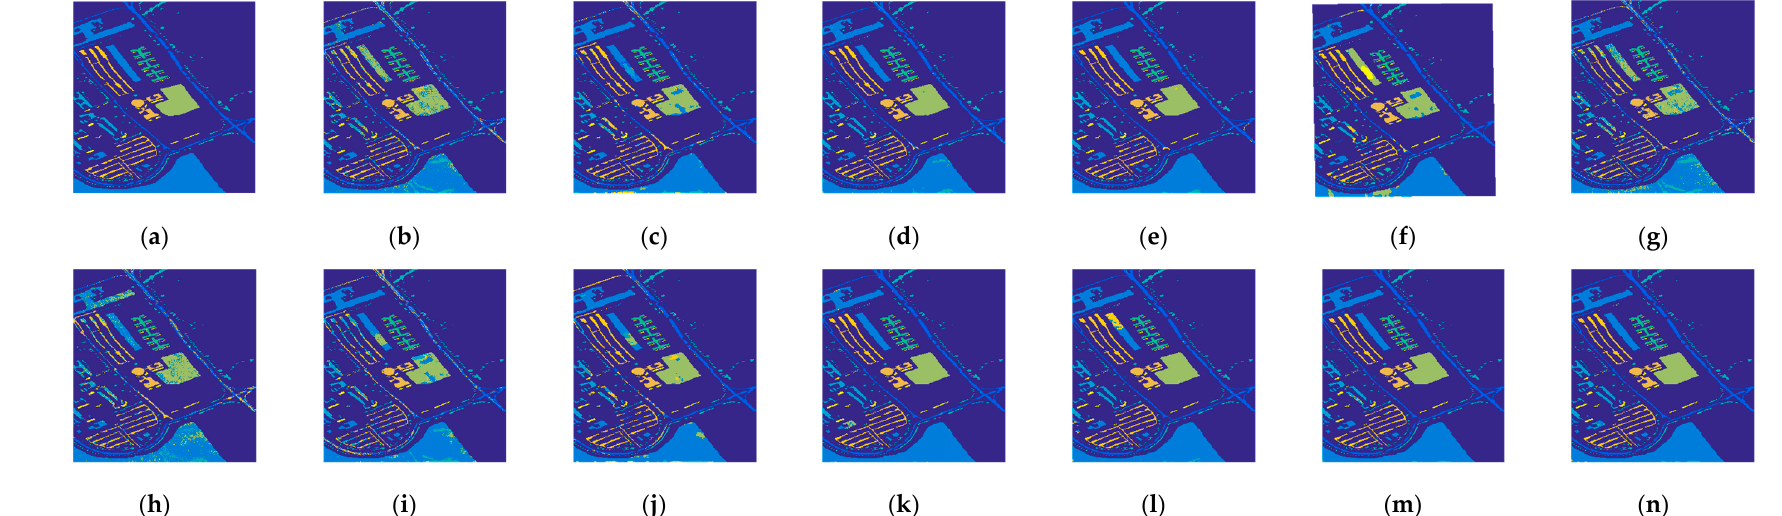
Figure 4. Results for the Pavia University dataset with about 30 training samples per class. ( a ) Ground truth. ( b ) KSVM (OA = 81.89). ( c ) SVM-CK (OA = 89.42). ( d ) FF-SVM (OA = 97.77). ( e ) JDFFF-SVM (OA = 98.50). ( f ) SMLR-SPATV (OA = 90.14). ( g ) GELM (OA = 79.16). ( h ) KELM (OA = 80.93). ( i ) GELM-CK (OA = 83.95). ( j ) KELM-CK (OA = 90.99). ( k ) GELM-FF (OA = 99.12). ( l ) KELM-FF (OA = 98.71). ( m ) GELM-JDFF (OA = 99.43). ( n ) KELM-JDFF (OA = 99.39).